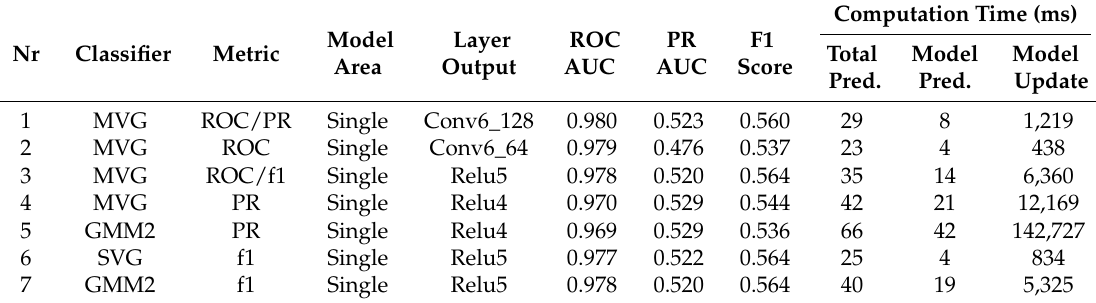
Table 1. Shows seven top performing configurations in terms of computation time and three accuracy